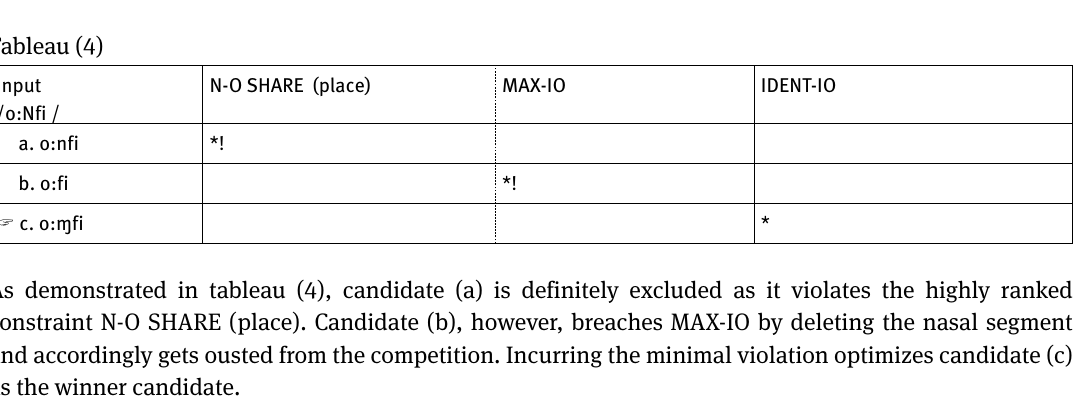
Tableau (4) further validates such constraint hierarchy interaction to optimize the winner candidate [o:ɱfi] ‘lecturing